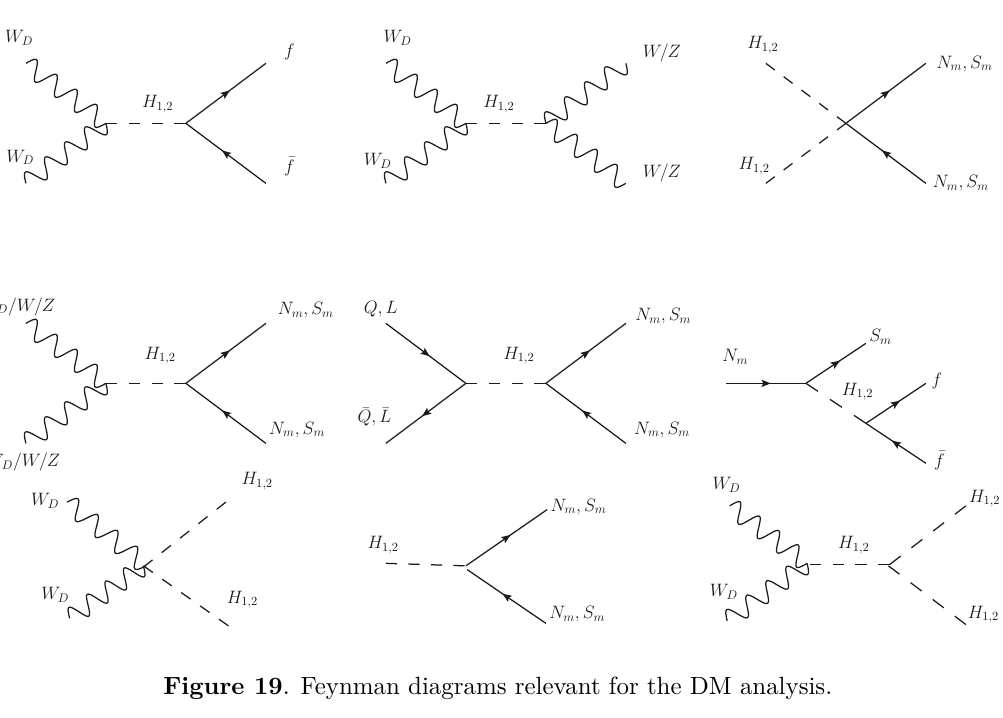
Figure 19 . Feynman diagrams relevant for the DM analysis.